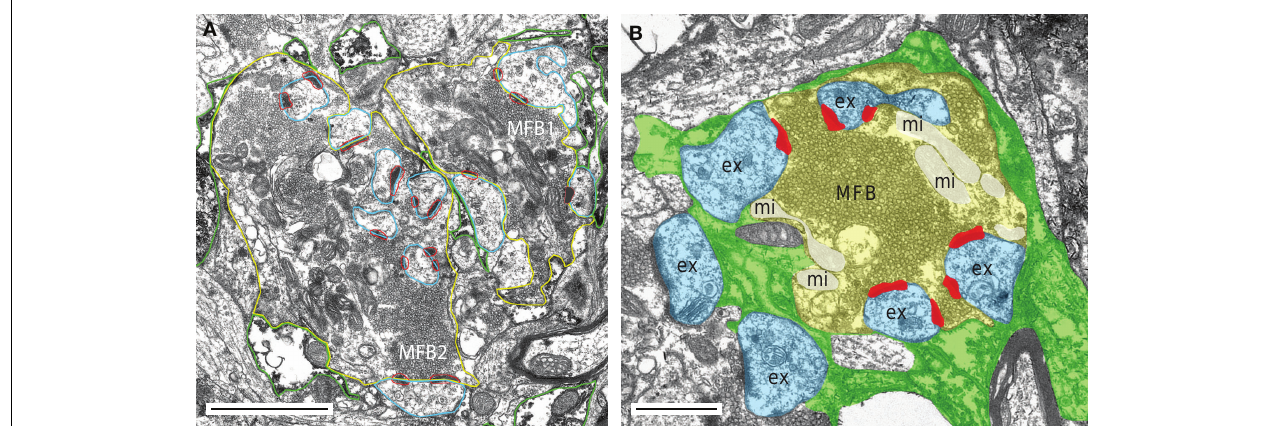
astrocytic processes (highlighted in green) as revealed by glutamine synthetase pre-embedding immunohistochemistry. The surface of an individual MFB (in light yellow), its postsynaptic spiny excrescences (ex; in light blue) was surrounded by several astrocytic processes (in green). Note, that the fi ne glial processes do not reach the AZs (in red) and the synaptic cleft. The mitochondria (mi) within the MFB are highlighted in white. Scale bar: 1